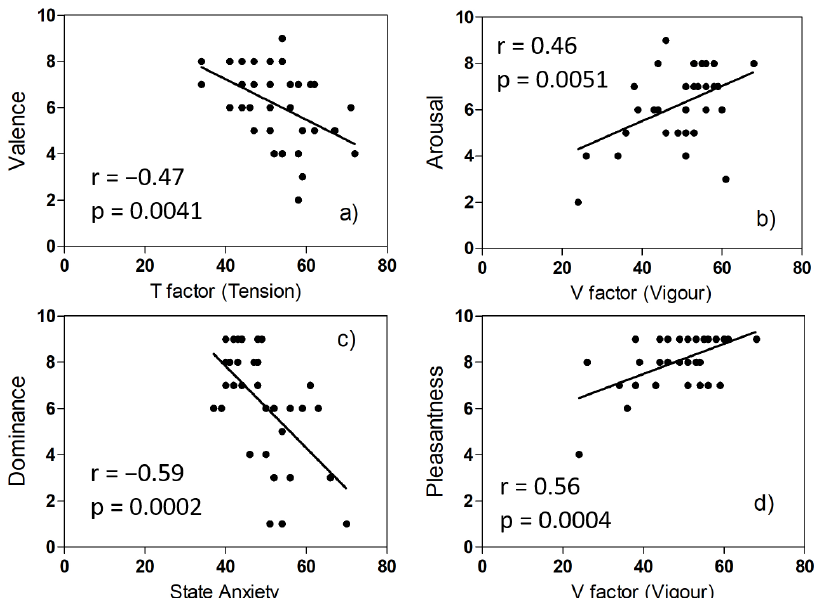
Figure 5. Correlation plots of SAM scores and mood or anxiety values: ( a ) video F (low arousal, high valence), ( b ) video D (high arousal, high valence), ( c ) video A (low arousal, low valence), ( d ) video D (high arousal, high valence).